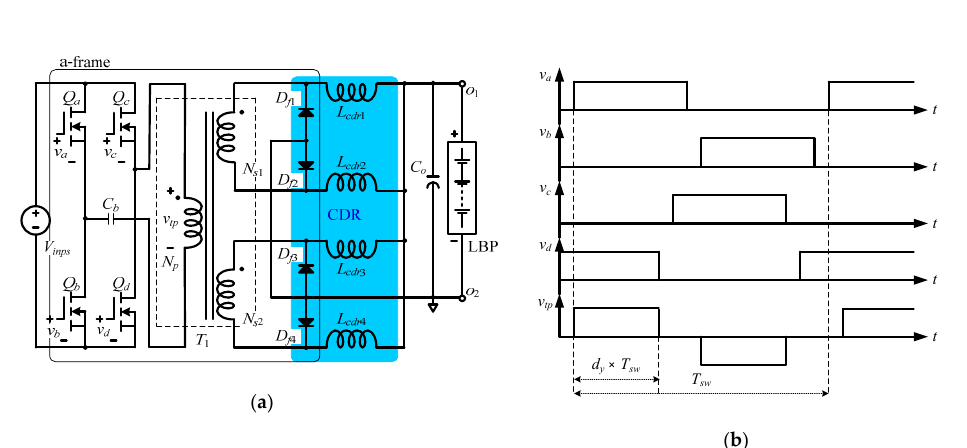
Figure 4. PSFB-PCDR circuit schematic and operating timing. ( a ) Circuit scheme. ( b ) Operating timing diagram.